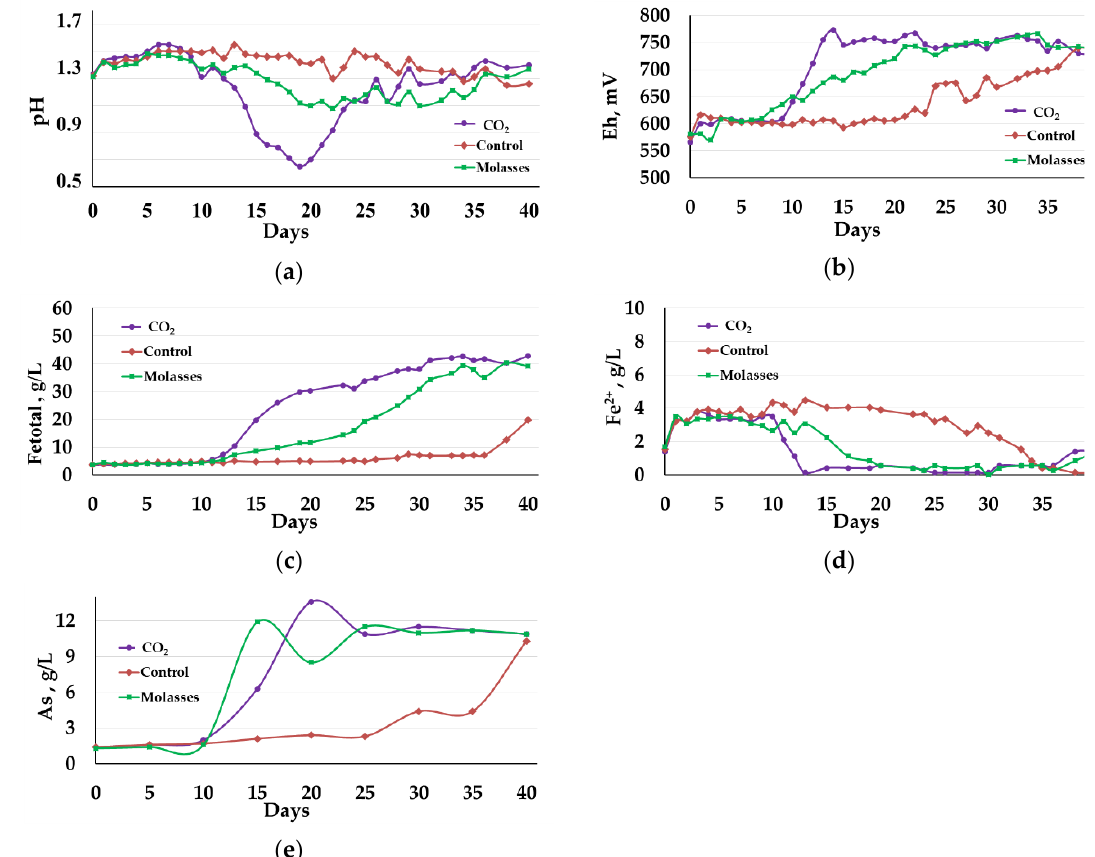
Figure 1. Changes in the liquid phase parameters during the bio-oxidation of the concentrate at 40 °C: ( a ) — pH; ( b ) — Eh; ( c ) — total concentration of Fe 3+ and Fe 2+ ions (g/L); ( d ) — concentration of Fe 2+ ions (g/L); ( e ) — concentration of arsenic (g/L).